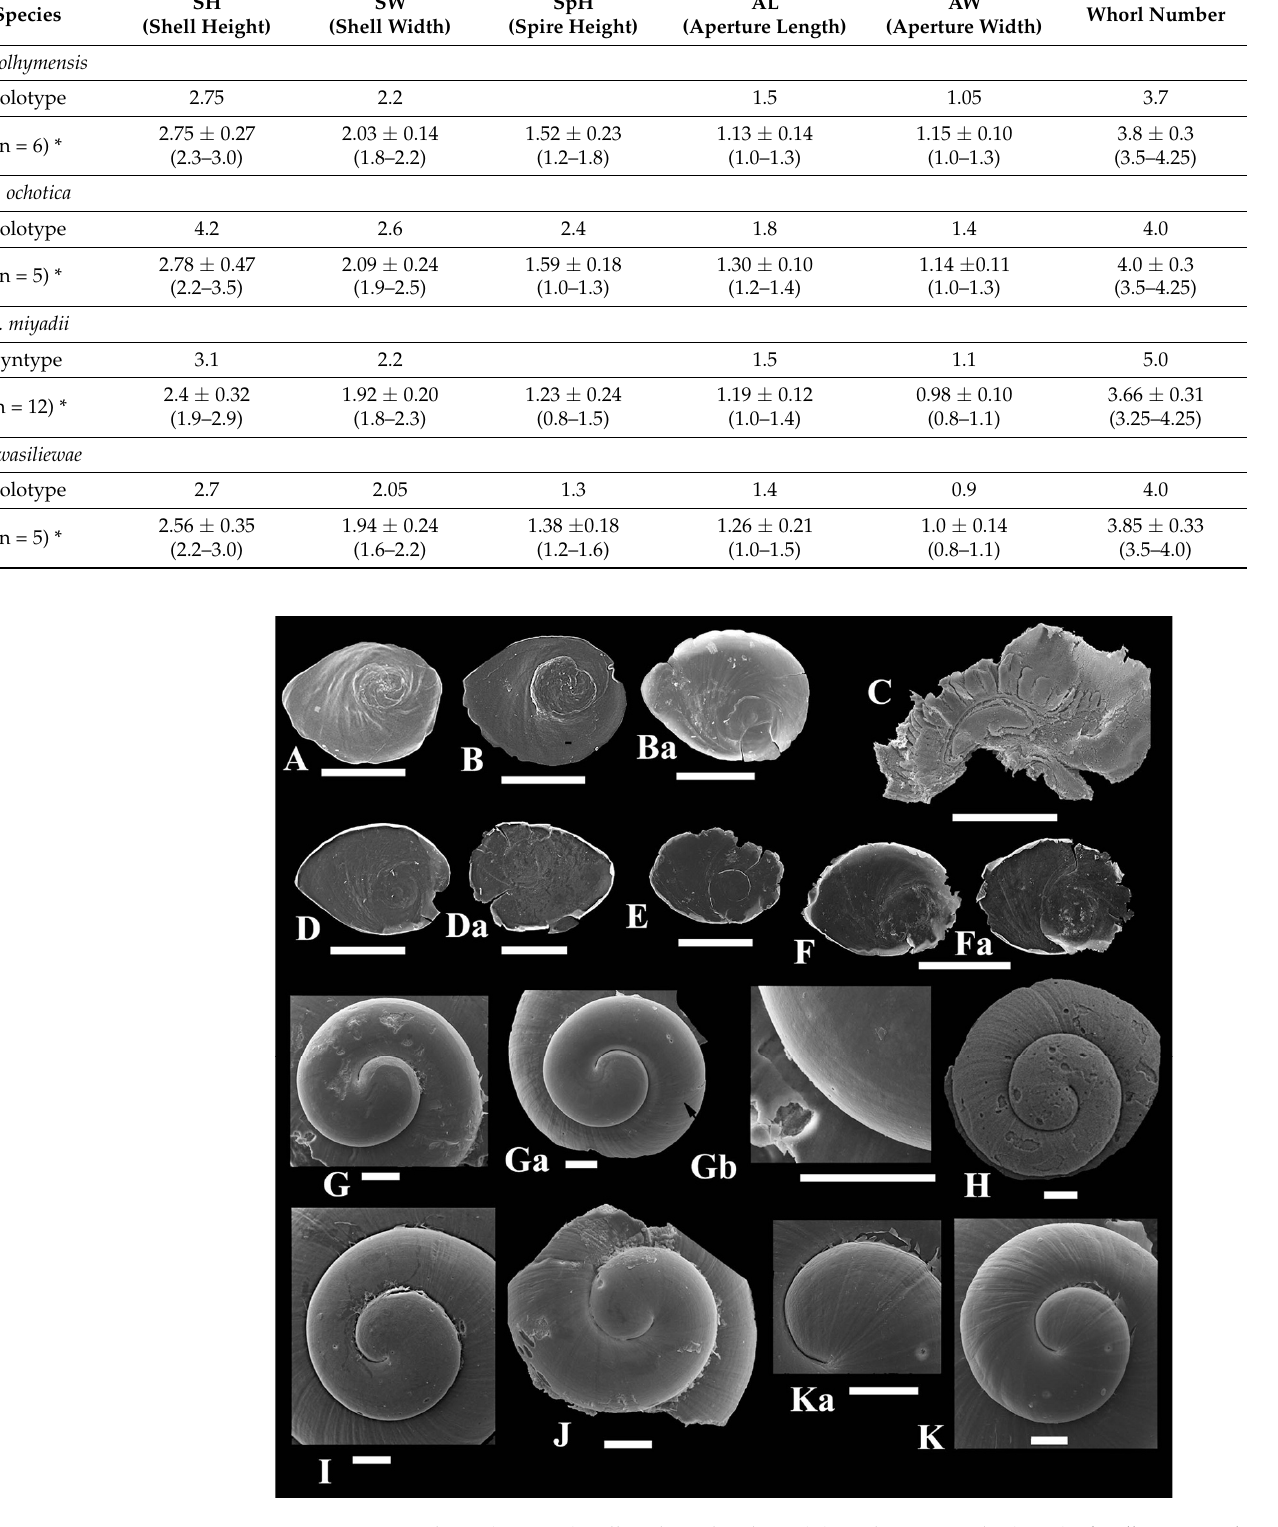
Figure 3. Operculums ( A , B , D , F ), gill with osphradium ( C ), and protoconchs ( G – K ) of Kolhymamnicola species. ( A , H ) K. kolhymensis , IBSS, No. 1418. ( B , C , G – Gb ) K. ochotica IBSS, No. 4325. ( F , Fa , I ) K. wasiliewae , IBSS, leg. Makarenko & Prozorova. ( D , Da , K , Ka ) K. miyadii from Shumshu Island, ZIN, No. 2. ( E , J ) K. miyadii from Zelenyi Island, IBSS, No. 518. Scale bars: ( A – F ) 0.5 mm, ( G – K ) 100 μ m. Soft body anatomy. The soft body is pale-yellow, with black pigment on the snout and along the edges of the tentacles (Figure 5Da,Db,E). Gill and osphradium without pig- mentation, gill with broadly triangular filaments, 24–32 in numbers, osphradium wide, slightly posterior or middle positioned, about 1/3 times shorter than gill (Figure 3 С ). Cer- ebral ganglions are dark-grey pigmented. Style sac length is less than stomach length. Di- gestive gland slightly brown with a single opening to the stomach. Caecum is absent. Female reproductive system. Ovary consists of the simple lobes, albumen gland in dorsal view is longer than capsule gland. Coiled oviduct represents a simple colorless loop; its right part is sometimes expanded. Starobogatov and Budnikova [11] thought that the right part of the loop functions as a bursa; however, our observations do not support this opinion. Seminal receptacle poorly distinguished in some dissected females (Figure